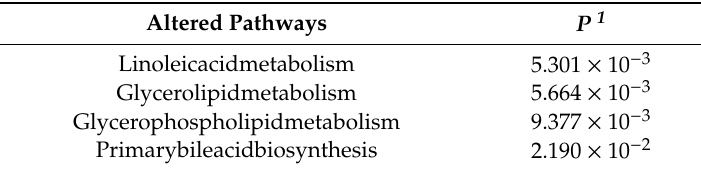
Table 2. Altered pathways associated with PDAC.